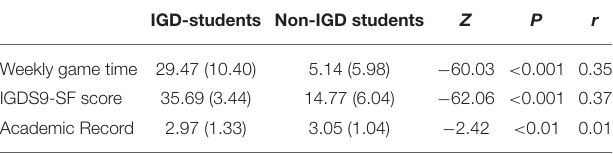
TABLE 2 | Validation of IGD classification ( n = 28,689).